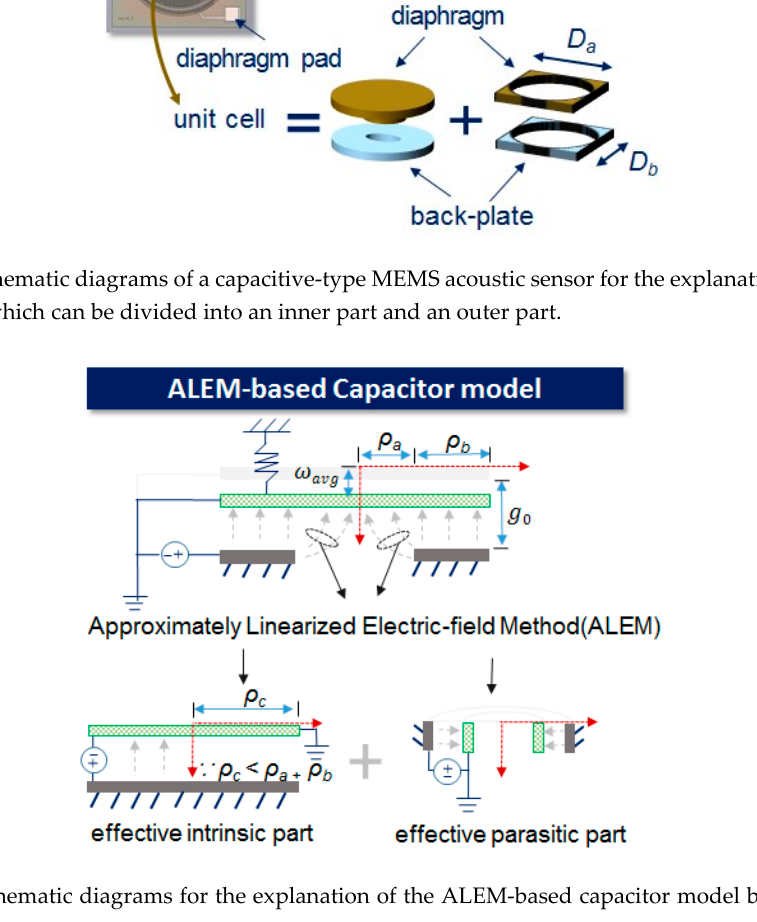
Figure 2. Schematic diagrams for the explanation of the ALEM-based capacitor model based on the vector